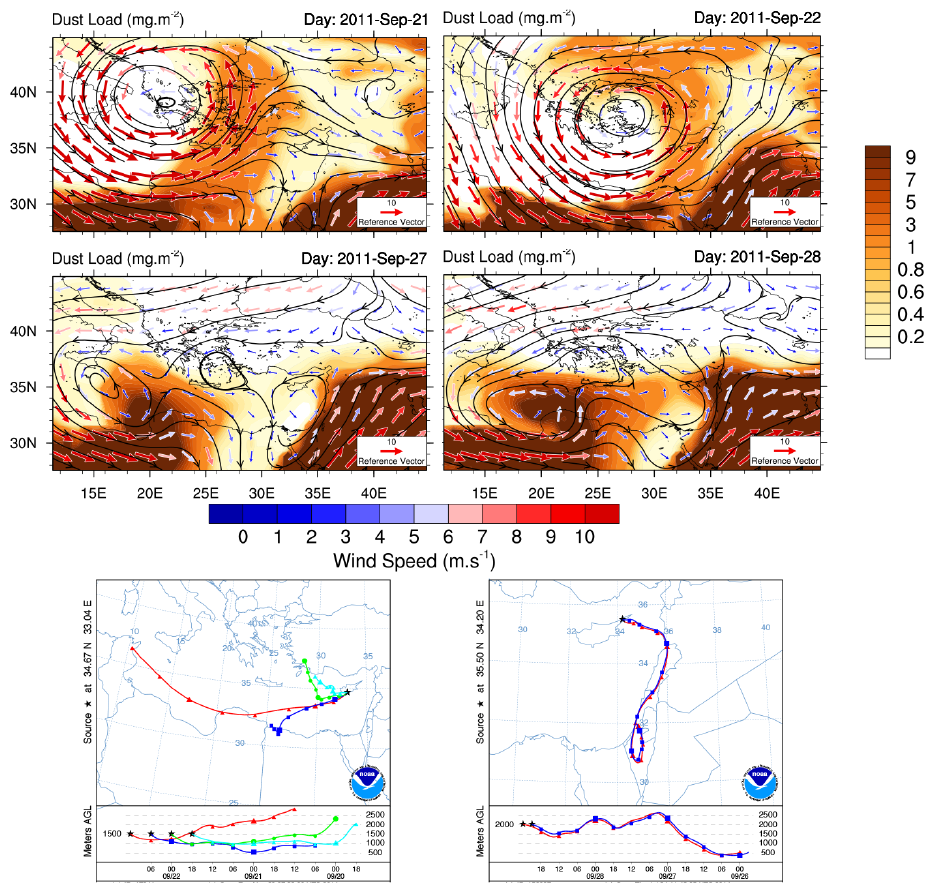
Figure 7. Daily average dust load over the eastern Mediterranean and HYSPLIT model backward trajectories ending at 12:00UTC 22 September at the CUT-TEPAK station and 21:00 on 28 September 2011 at 35.5 ◦ N and 34.3 ◦ E for both dust outflow